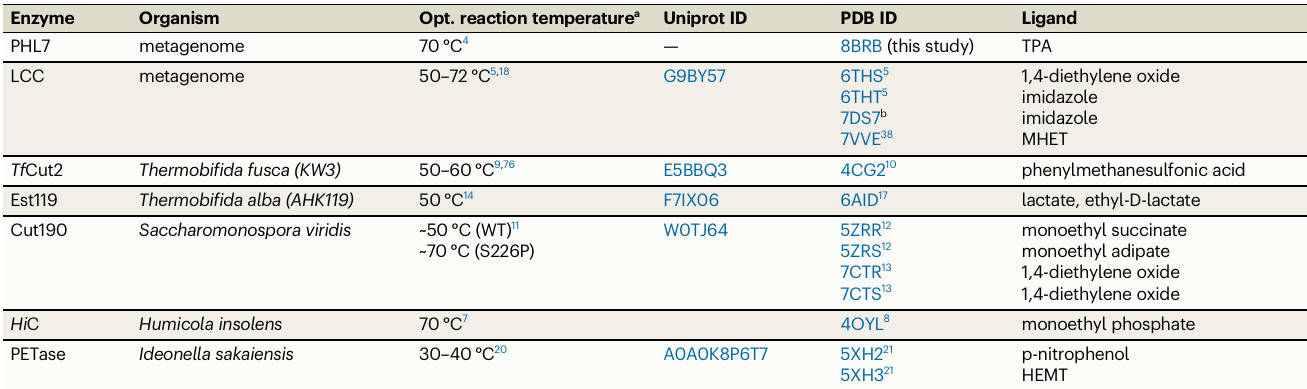
Table 1 | Overview of ligand-cocrystal structures of polyester hydrolases